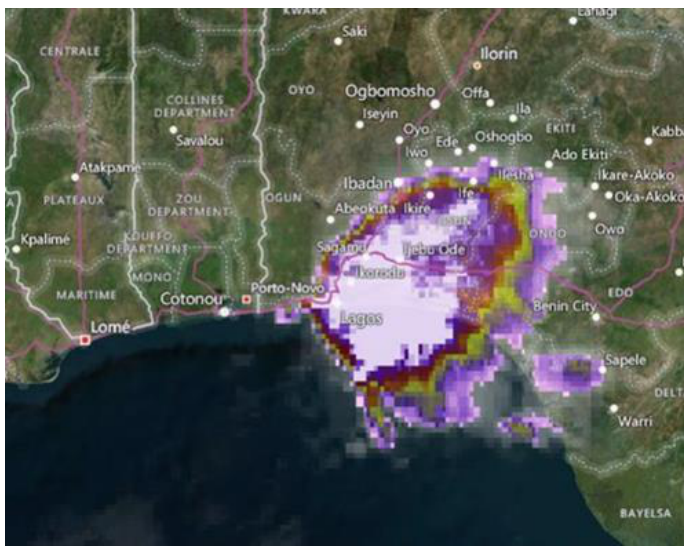
Figure 12. Bad weather conditions over the HFSWR sites.